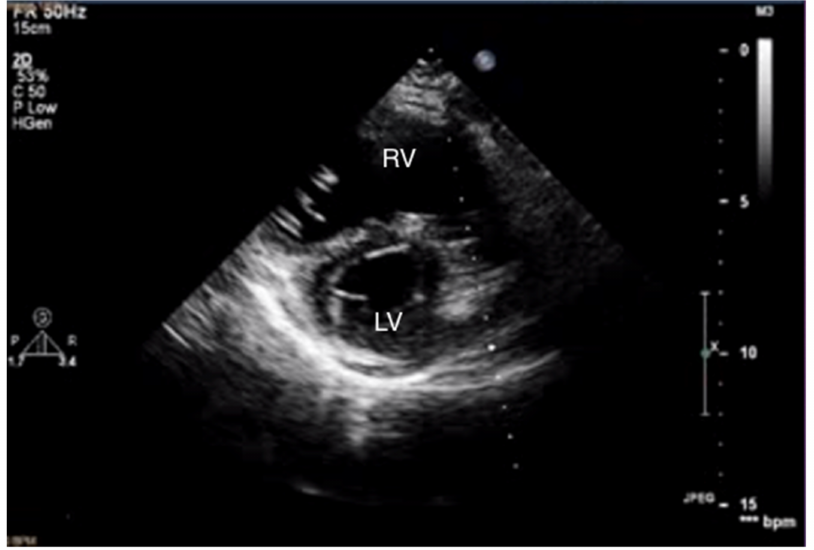
Figure 2. Enlarged right ventricle. 2D-TTE, parasternal short-axis view (PSAX). RV: right ventricle, LV: left